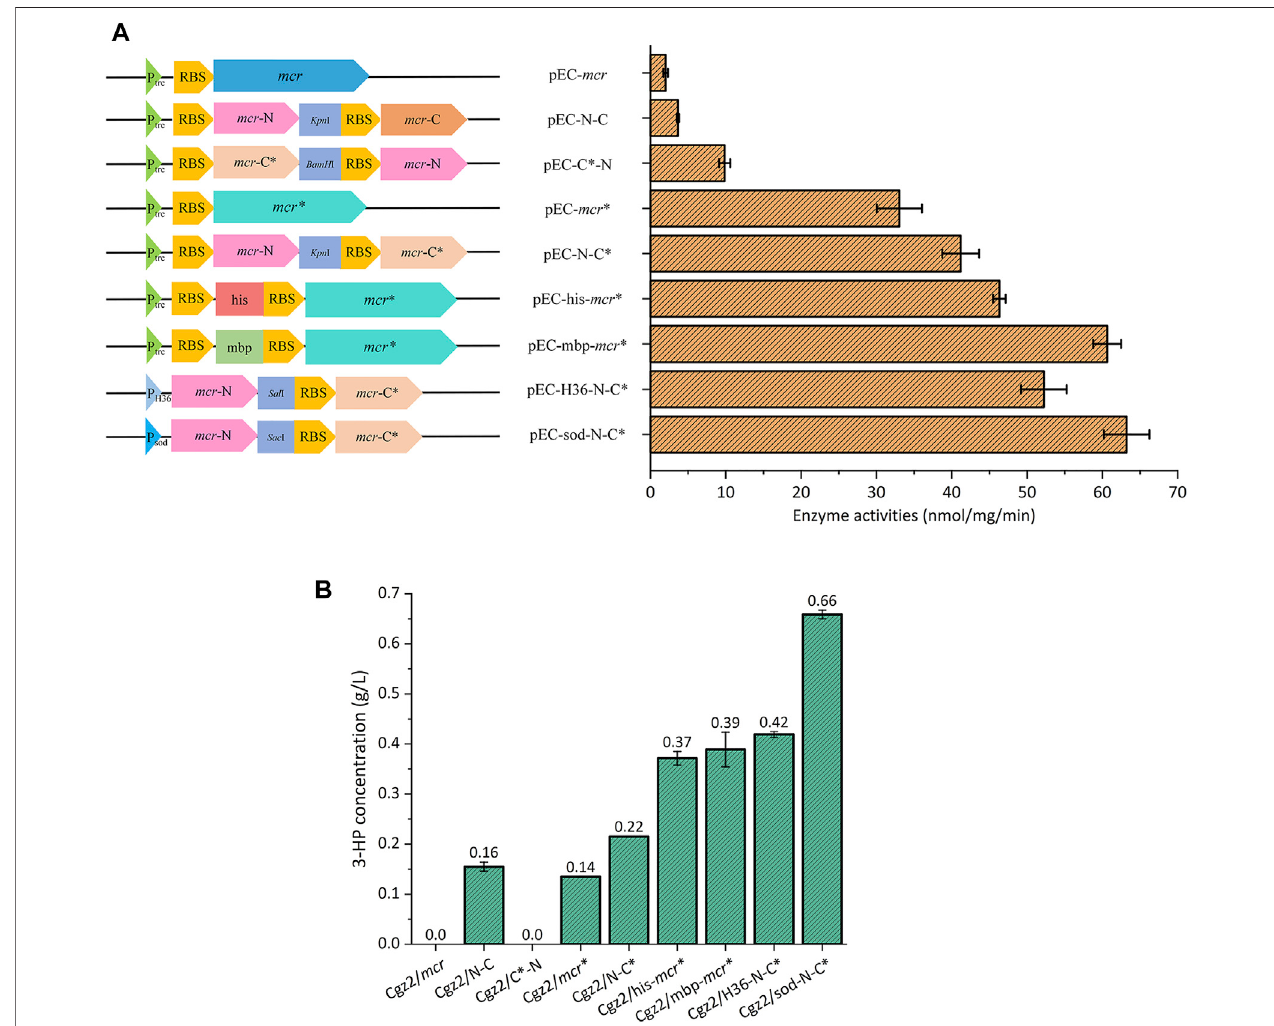
FIGURE2| Overviewsofaseriesof mcr overexpressionplasmidsandtheirapplicationsin3-HPproduction. (A) Schematicdrawingofdifferent mcr overexpression plasmids, and their respective MCR enzyme activities. (B) 3-HP concentrations of Cgz2 series strains.